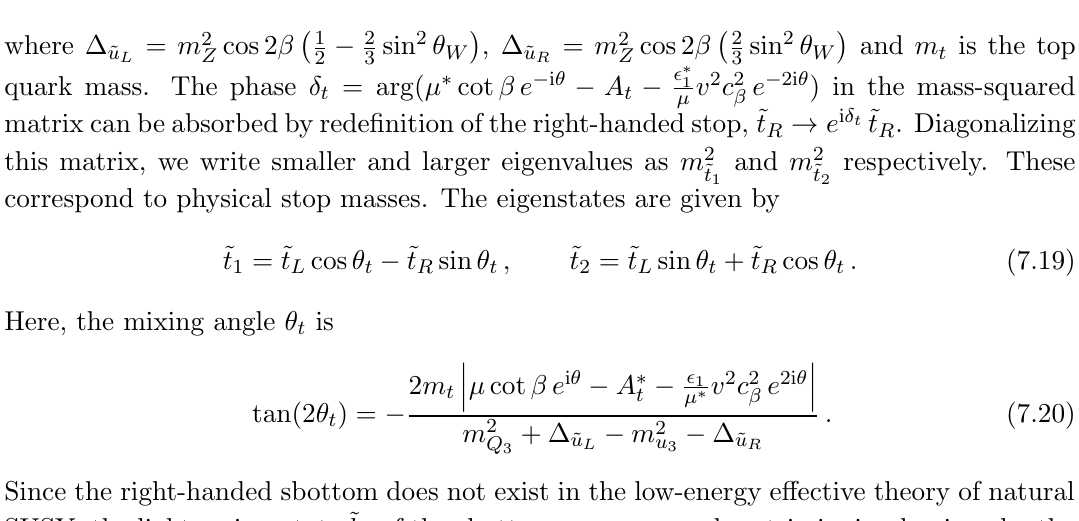
Figure 15 . The lightest neutral Higgs boson mass (in unit of GeV) as a function of j (cid:15) 1 ; 2 j (left) and choice of j (cid:15) j to realize the correct Higgs mass (right) in the BMSSM scenario. We take tan (cid:12) = 5 and m A = 400 GeV. For the left panel, we assume ~ (cid:30) 1 ; 2 (cid:17) (cid:25) (cid:0) (cid:30) 1 ; 2 = 0 : 1. The dashed lines denote the tree-level Higgs mass. The green shaded region may give the correct Higgs mass, taking account of radiative corrections from top/stop loops. For the right panel, we assume j (cid:15) 1 j = j (cid:15) 2 j and the tree-level Higgs mass at 120 GeV, relying on the radiative corrections to explain the